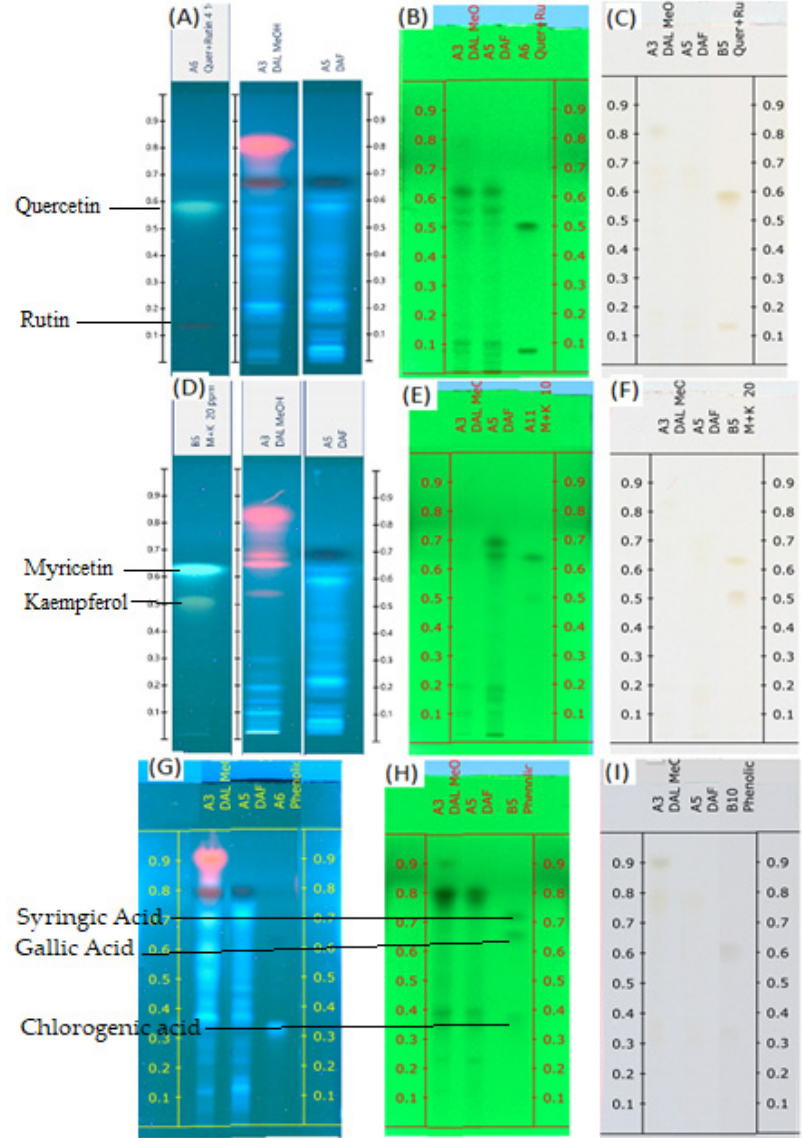
Figure 1. TLC profiles of DAL and DAF ( A ) Flavonoids (quercetin and rutin) at 366 nm; ( B ) Flavonoids (quercetin and rutin) at 254 nm; ( C ) Flavonoids (quercetin and rutin) at visible light; ( D ) Flavonoids (myricetin and kaempferol) at 366 nm; ( E ) Flavonoids (myricetin and kaempferol) at 254 nm; ( F ) Flavonoids (myricetin and kaempferol) at visible light; ( G ) Phenolic acids at 366 nm; ( H ) Phenolic acids at 254 nm; ( I ) phenolic acids at visible light.